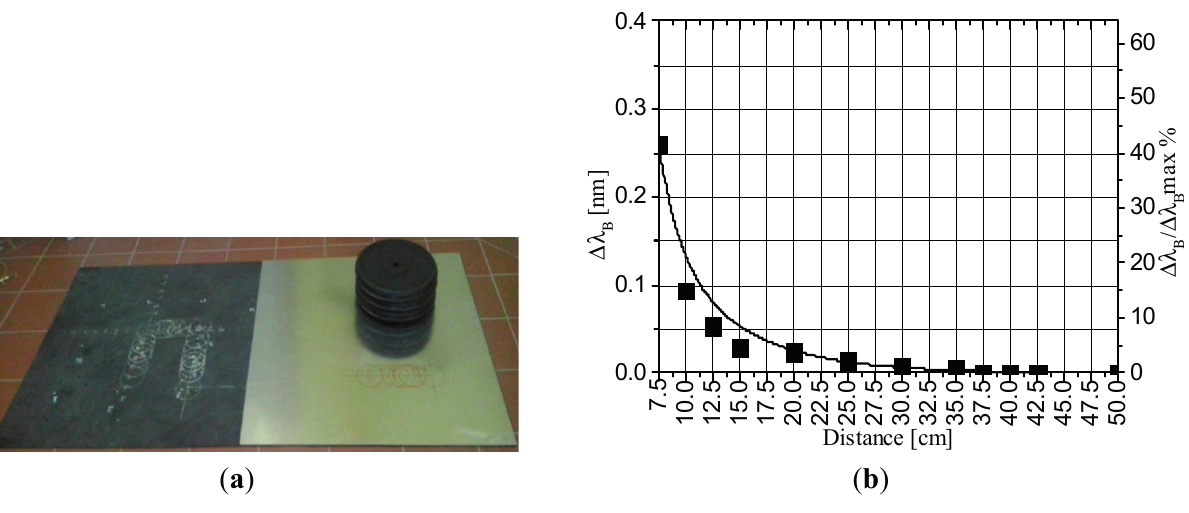
Figure 12. ( a ) Picture of the mat with aluminum plate; ( b ) Bragg wavelength shift versus the distance from the FBG fitted with an exponential